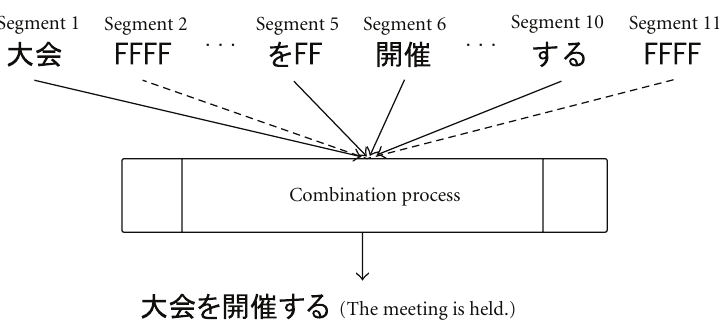
Figure 7: Example of combination process.